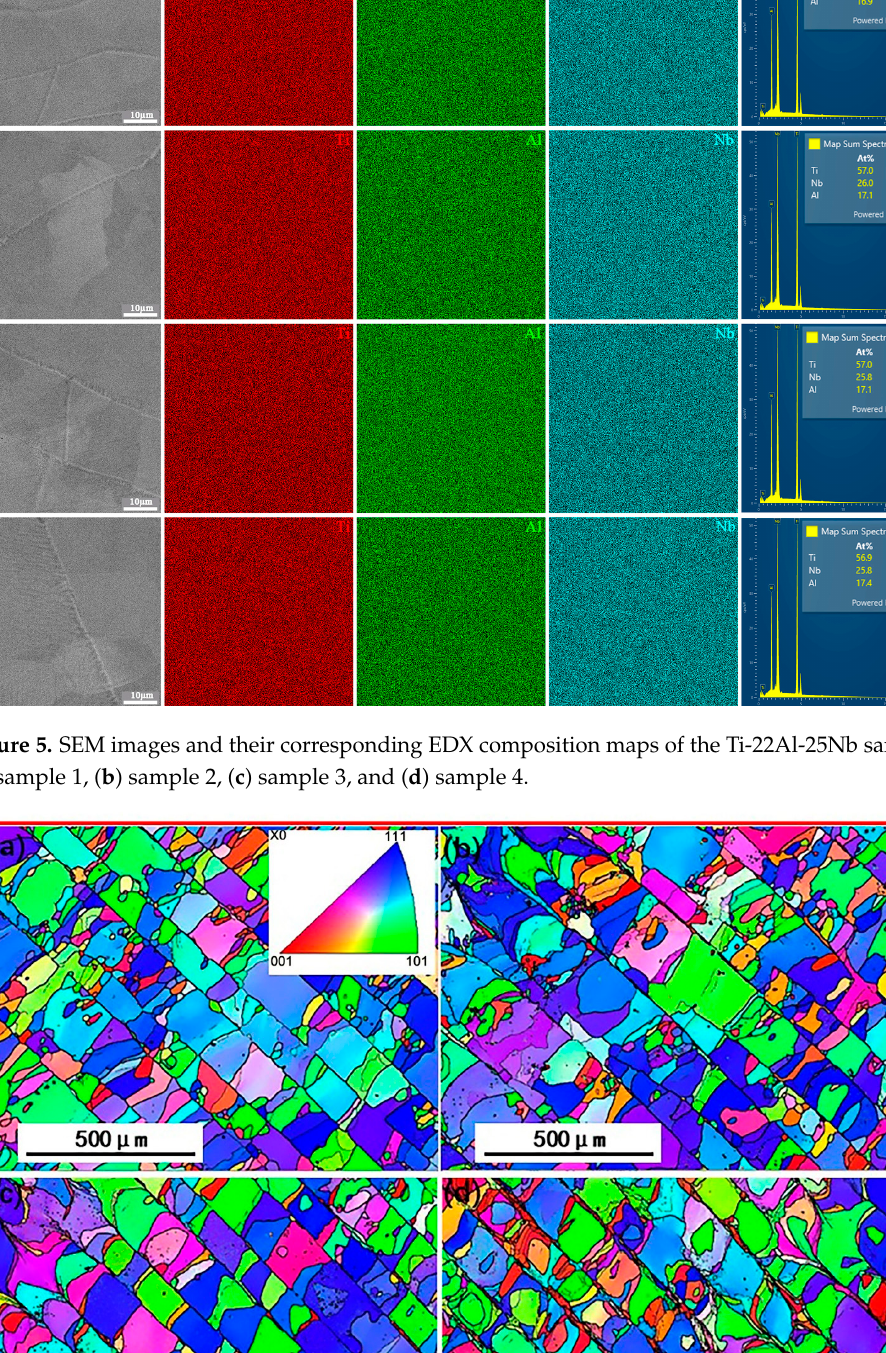
Figure 4. Microstructural characteristics of Ti-22Al-25Nb identi fi ed by SEM: ( a ) S1, ( b ) S2, ( c ) S3, and